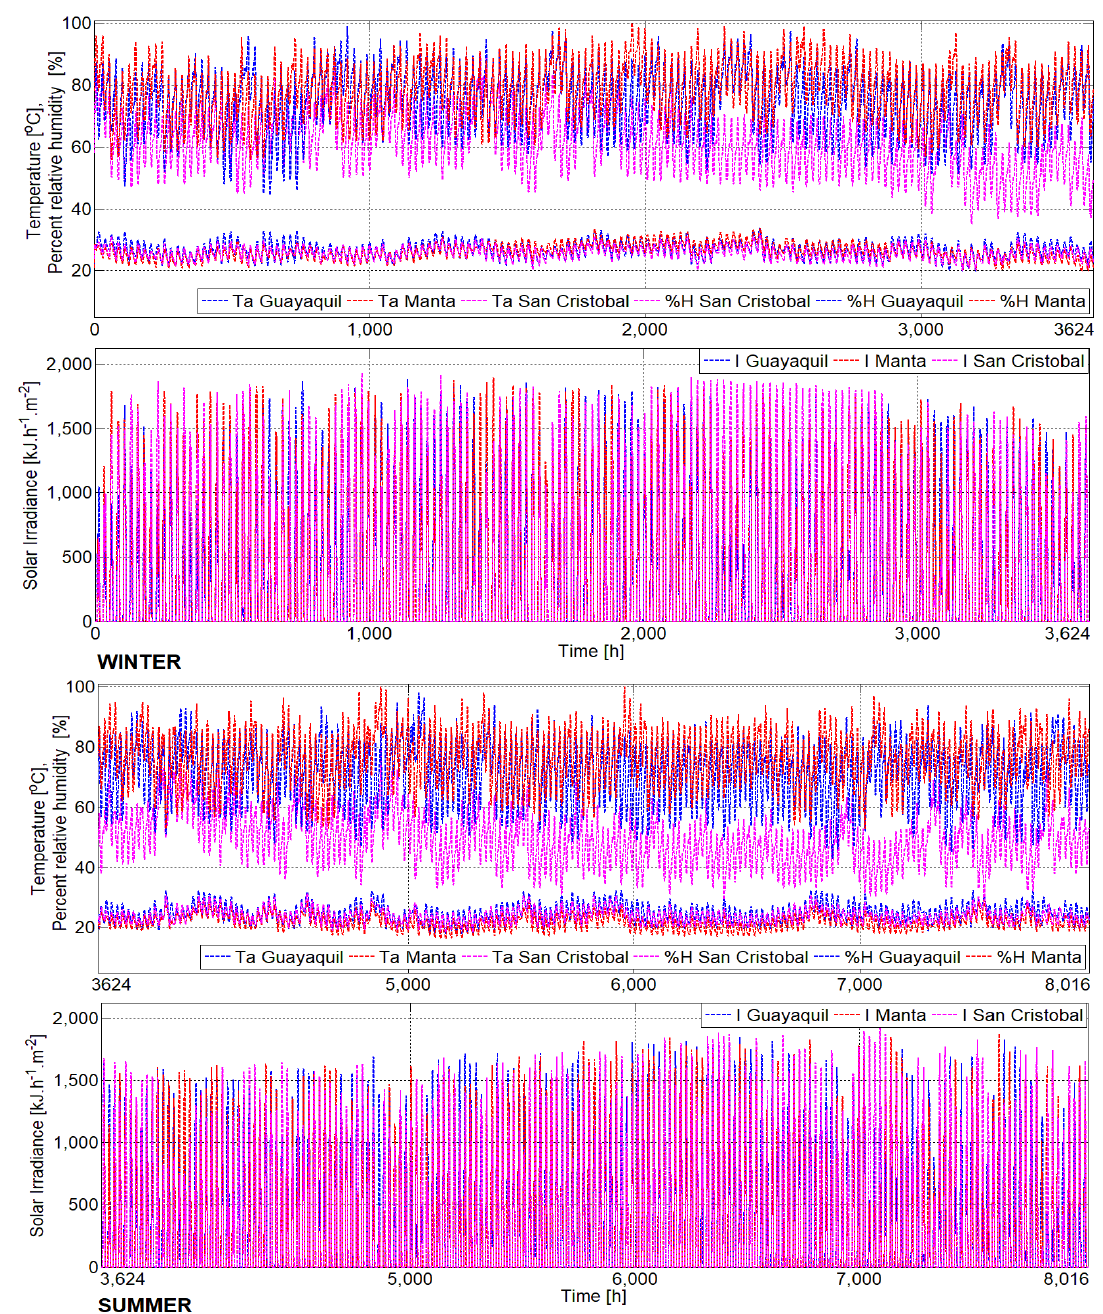
Figure 10. Solar irradiance in three selected sites of Ecuador from summer and winter.